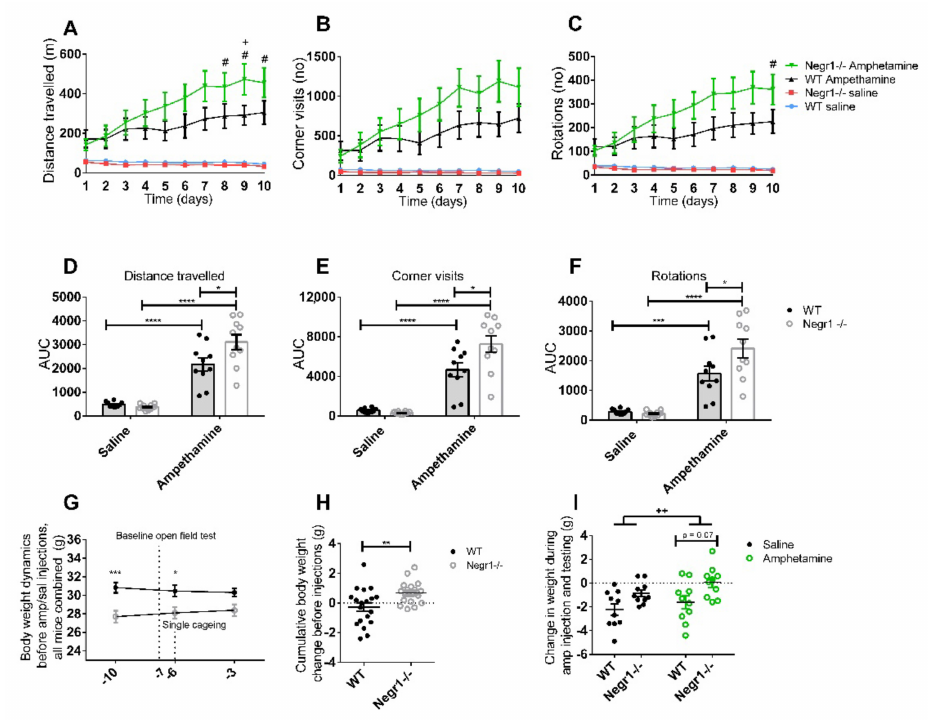
Figure 2. Negr1 − / − mice are more sensitive to chronic amphetamine administration. Effect of chronic amphetamine on ( A , D ) distance traveled, ( B , E ) corner visits, and ( C , F ) rotations in the open field test. In G and H saline/amphetamine groups have not been separated yet, the body weight change is a reaction to non-pharmacological environmental manipulations. ( G ) Body weight dynamics measured during 1 week of the period before amphetamine injection (from day -10 until day -3) ( H ). Cumulative body weight change before saline/amphetamine injections (from day -10 until day -3). ( I ) Body weight change caused by chronic saline or amphetamine injections and behavioral testing (from day 1 until day 10). Data represents mean ± SEM, +— p < 0.01—the difference in treatment